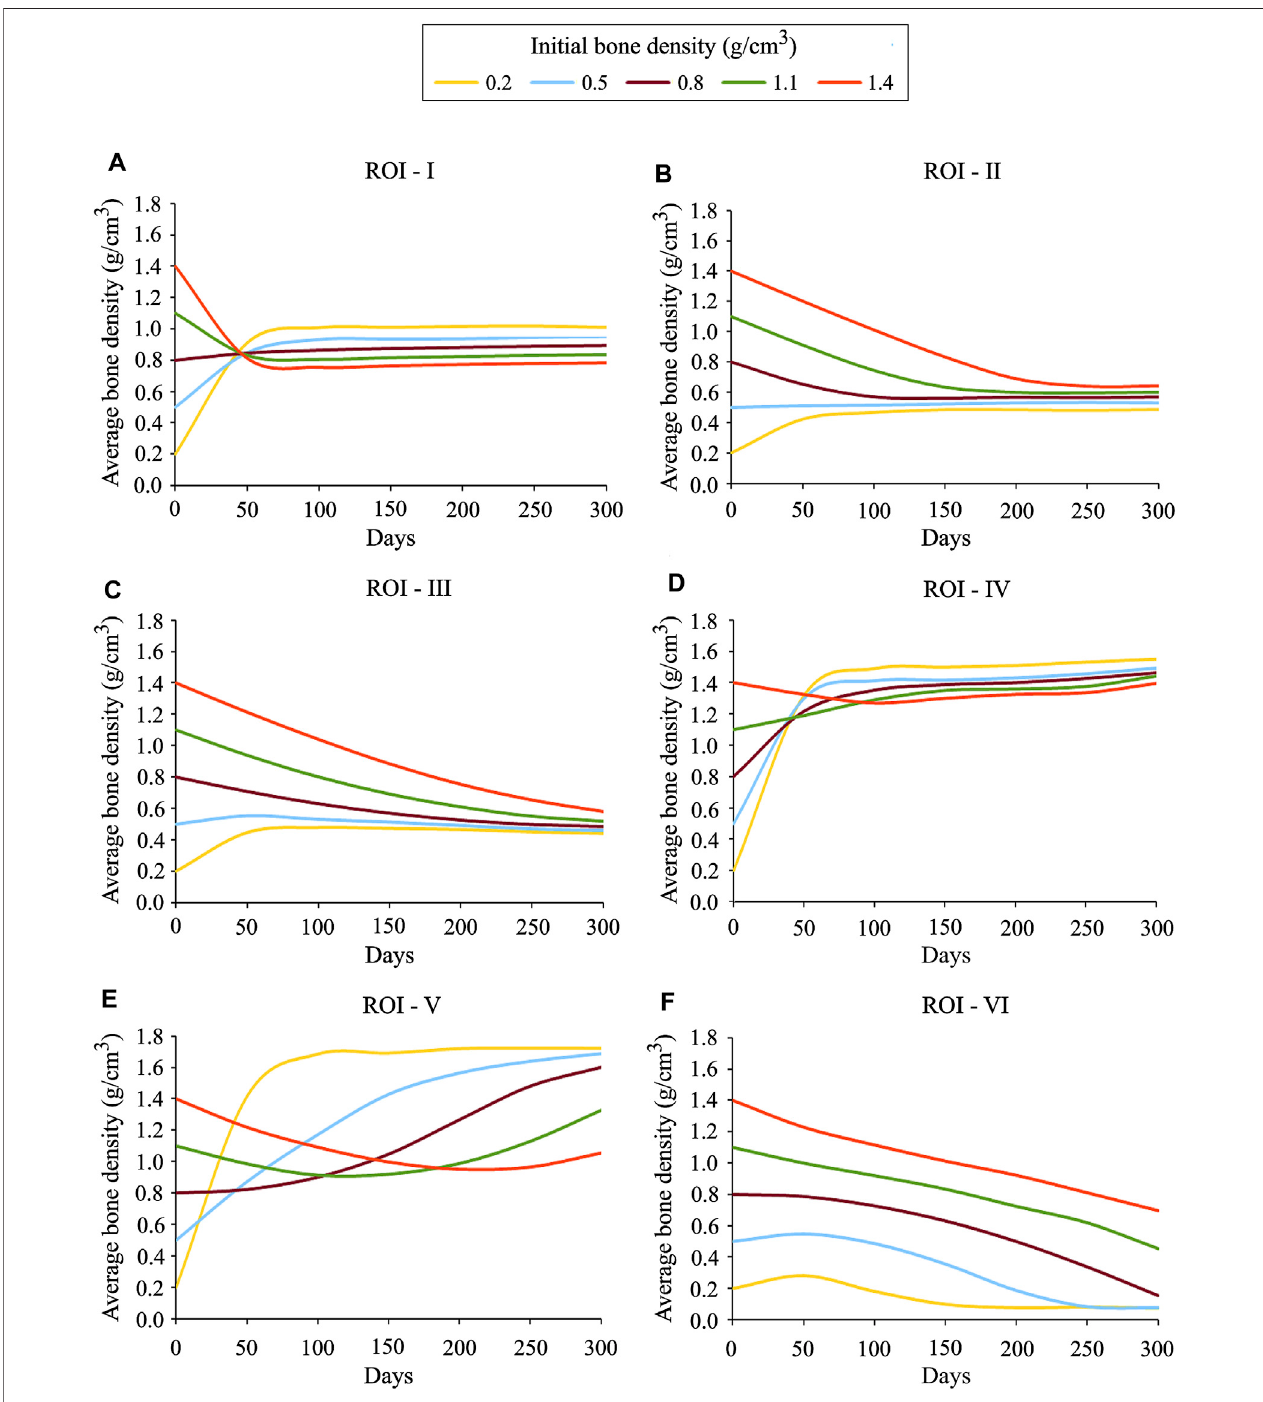
FIGURE 8 | Average bone density evolution in the local regions of interest marked in Figure 6C : (A) ROI I (B) ROI II (C) ROI III (D) ROI IV (E) ROI V and (F) ROI VI.